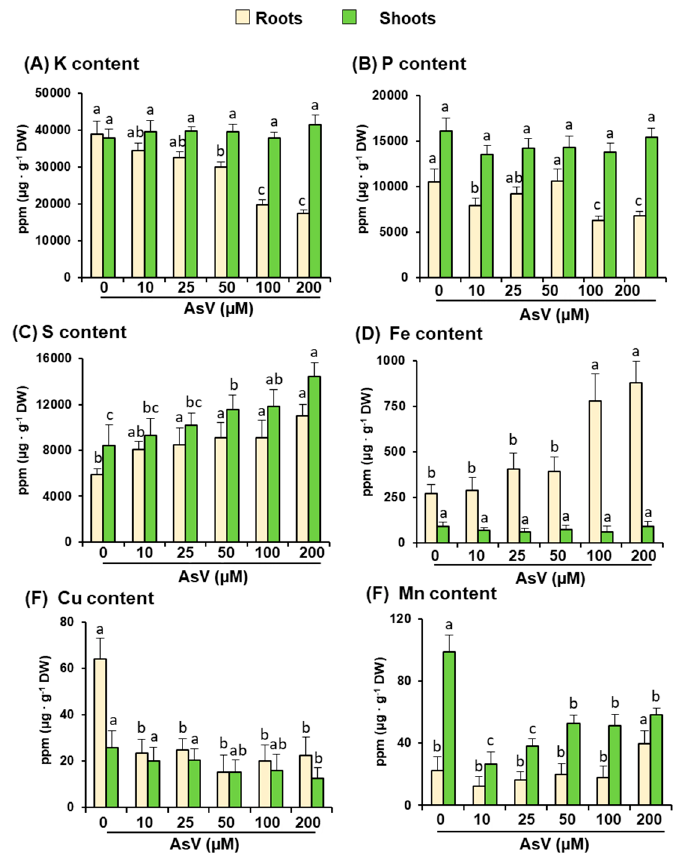
Figure 3. Content of K, P, S, Fe, Cu and Mn in roots and shoots of 26-d-old rice seedlings grown in hydroponic solutions supplemented the last 12 days with di ff erent AsV concentrations. ( A ) Potassium. ( B ) Phosphorus. ( C ) Sulfur ( D ) Iron. ( F ) Copper. ( E ) Manganese. Data are means ± SEM of at least three independent experiments. One-way Anova was used for comparisons between means using the program Statgraphics Centurion. Di ff erent letters over the columns for each organ (either shoot or root) indicate that di ff erences with respect to control (0 µ M AsV) values were statistically significant at p < 0.05.